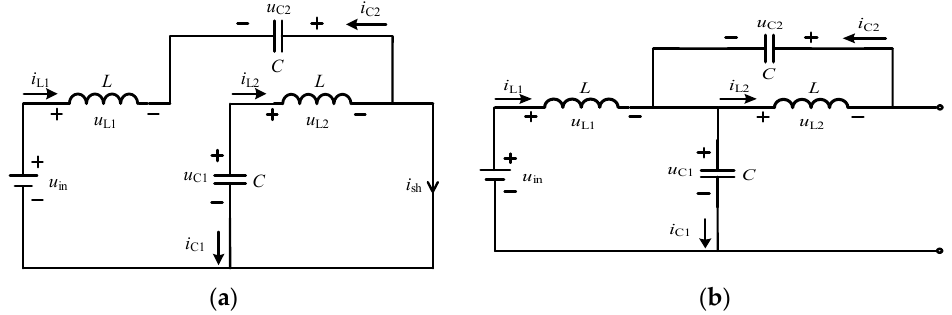
Figure 6. Equivalent circuits of the qZSI under different vectors: ( a ) shoot-through vector; ( b ) zero or empty vector.